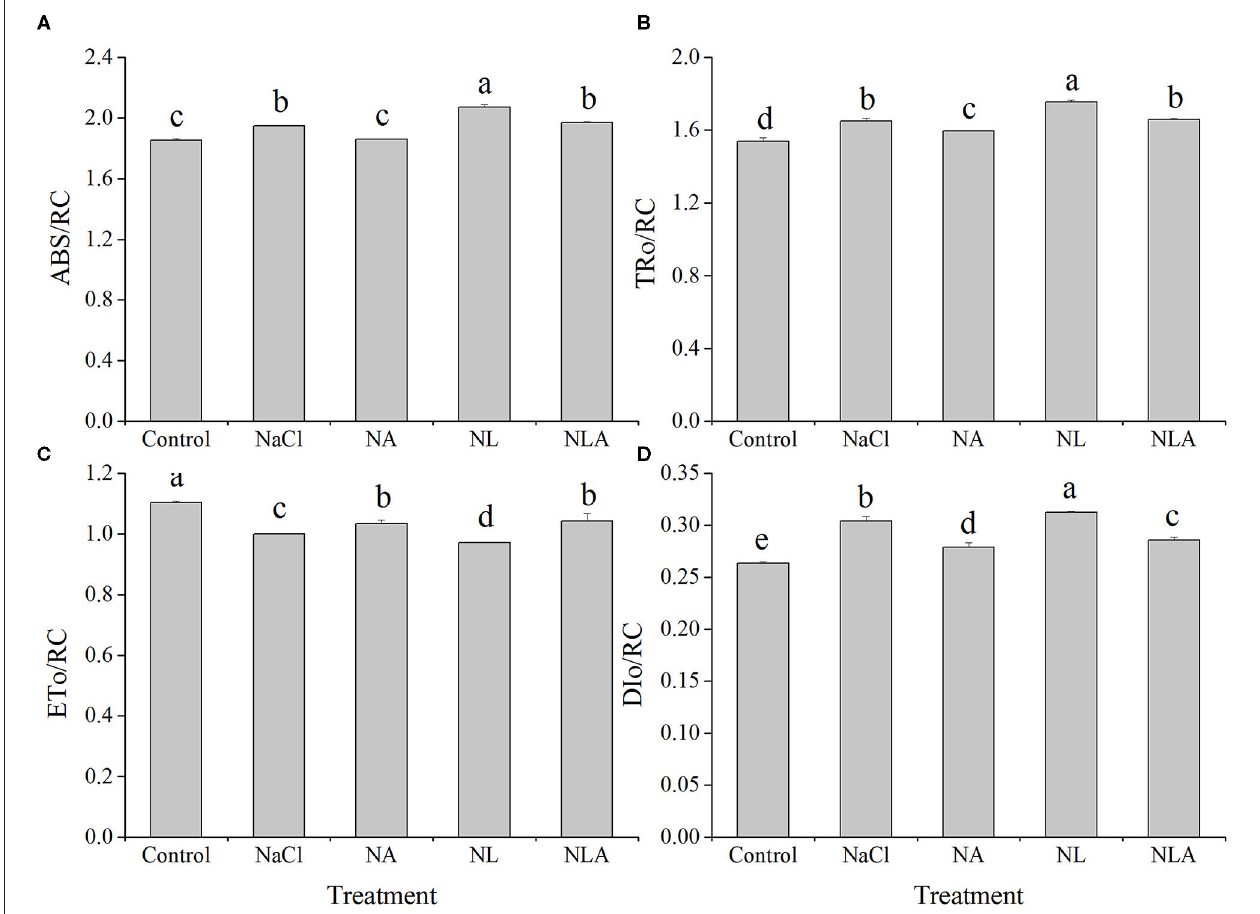
FIGURE 8 | Parameters of absorption flux per reaction center (RC) (ABS/RC) (A) , trapped energy flux per RC (at t = F o ) (TR o /RC) (B) , electron transport flux per RC (at t = F o ) (ET o /RC) (C), and dissipated energy flux per RC (at t = F o ) (DI o /RC) (D) in leaves of salt-stressed tomato seedling with or without exogenous ascorbic acid (AsA) and lycorine (LYC) spraying. Values are means ± SD ( n = 3). Different letters (a, b, c, d, and e) indicate significant difference at P < 0.05 among treatments. Error bar is smaller than the line at the top of the graph. Control, no added NaCl, no sprayed AsA and LYC; NaCl, added 100 mmol/L NaCl; NA, added 100 mmol/L NaCl and sprayed 0.5 mmol/L AsA; NL, added 100 mmol/L NaCl and sprayed 0.25 mmol/L LYC; NLA, added 100 mmol/L NaCl and sprayed 0.25 mmol/L LYC and 0.5 mmol/L